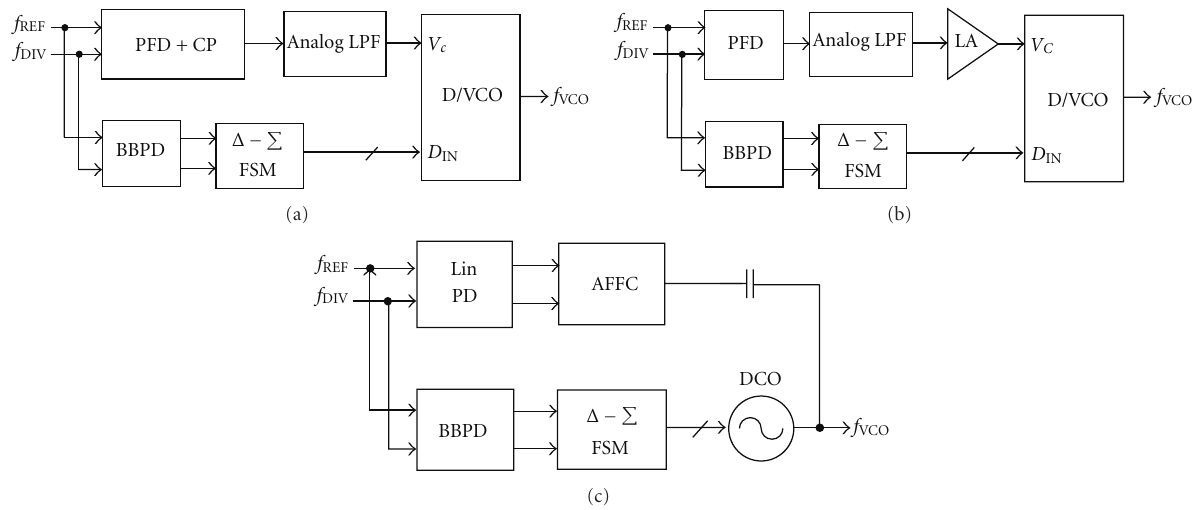
Figure 5: (a) PFD/CP based, (b) PFD/LA based, and (c) AAFC based.